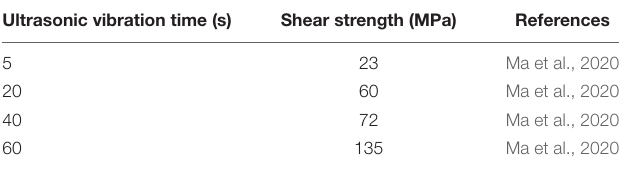
TABLE 3 | Ultrasonic vibration time (s) v/s shear strength (MPa). Ultrasonic vibration time (s) Shear strength (MPa)